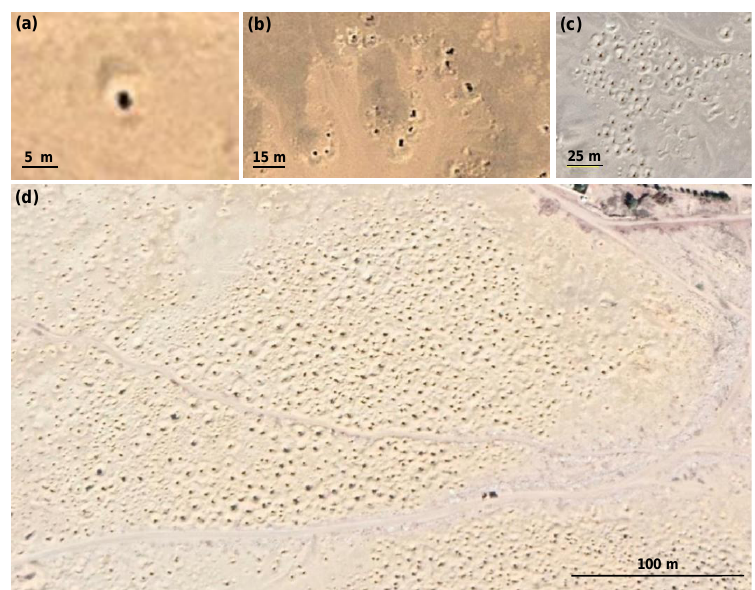
Figure 6. Examples of typical looting features in satellite very high resolution (VHR) optical images covering arid and desert sites: ( a ) single, isolated, circular looting pit; ( b ) low density clusters of looting pits; ( c ) high density cluster of looting pits; ( d ) extended looted areas with coalescence of looting pits. Google Earth images © 2019 Maxar Technologies.